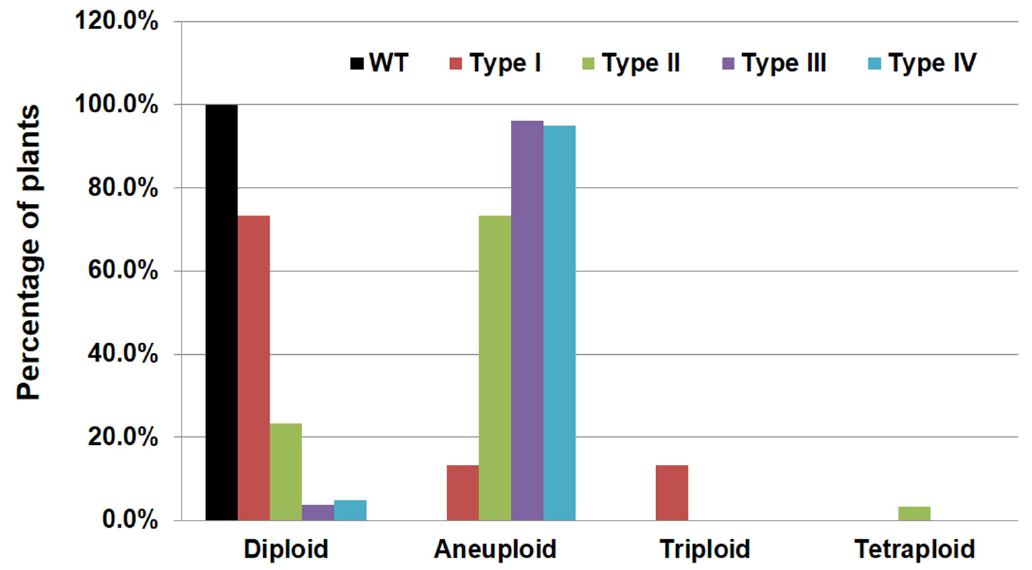
Figure 7. Ploidy analysis of different subtypes of ubc22-1 mutant. Forty-five type I, thirty type II, twenty-six type III and twenty type IV plants were analyzed. Leaf tissues of four-week-old plants were used, and nuclei were stained with DAPI. Thirty-eight WT (diploid) plants were used as references. Based on the nuclear DNA contents (4C peak values), the plants were sorted into the groups of diploids, aneuploids, triploids and tetraploids.